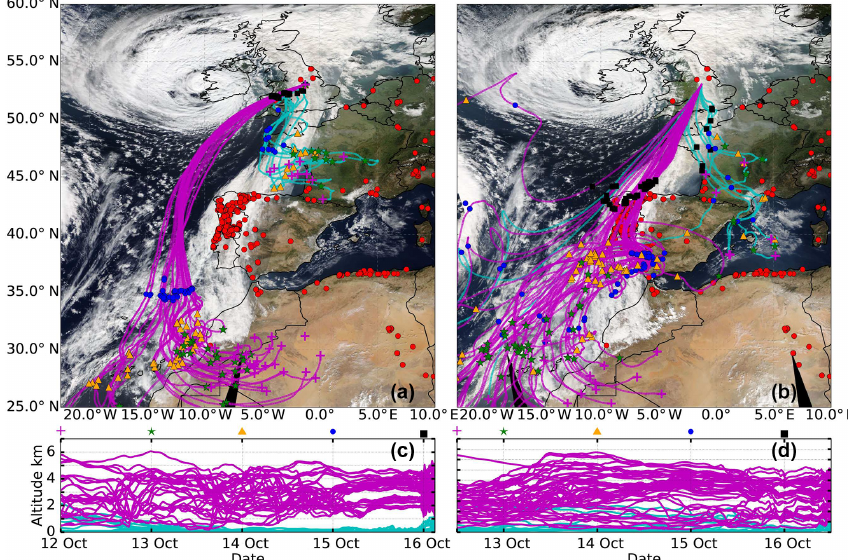
Figure 15. NAME back trajectories overlaid on MODIS AQUA composite images from 16 October 2017. Red dots on MODIS images show active forest fires. Approximate times of overpasses are 12:00UTC for the left-hand swath and 13:45UTC for the right. In (a) , back trajectories are for air masses arriving over Watnall at 03:00UTC and in (b) at 12:00UTC, on 16 October 2017 at the altitudes shown in (c) and (d) . Trajectories shown in cyan arrive at Watnall at altitudes under 1km, and trajectories shown in magenta arrive over 1km. The symbols shown on the trajectories themselves and on the top axis of (c) and (d) indicate the trajectory positions at 00:00 on each day (with the exception of the purple crosses on the right-hand plots, which mark the position at 12:00UTC on 12